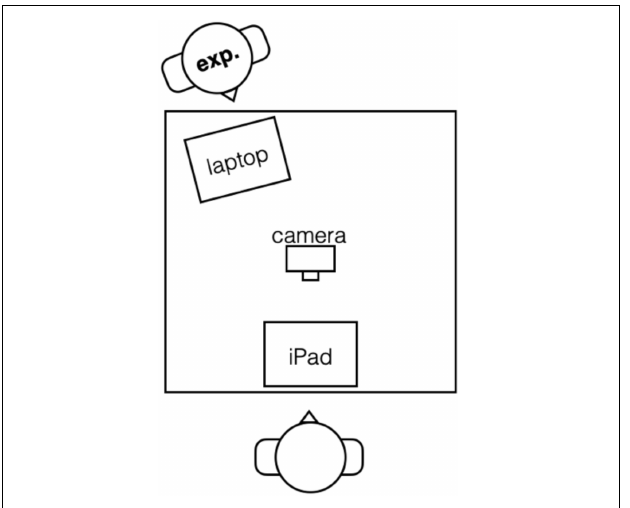
FIGURE 2 | Experiment setup: the participant sat across the table from the experimenter, who showed the images on an external screen placed in front of the